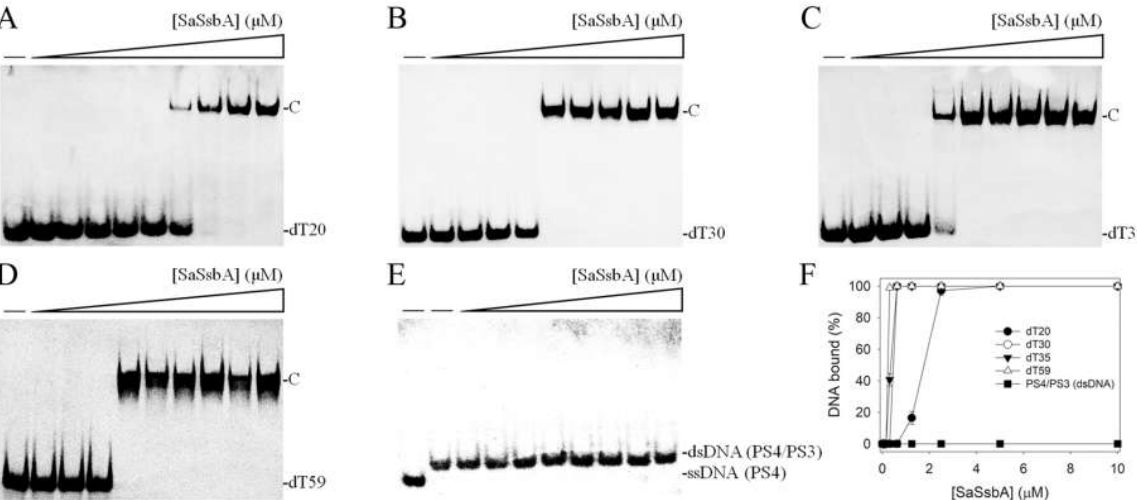
Figure 1. Binding of SaSsbA to ssDNA and dsDNA. Purified SaSsbA (0, 0.039, 0.078, 0.156, 0.312, 0.625, 1.25, 2.5, 5, 10 μM) was incubated with the biotin-labeled ssDNAs ( A ) dT20, ( B ) dT30, ( C ) dT35, and ( D ) dT59 at 37 °C for 60 min. ( E ) Results of binding test of SaSsbA to dsDNA. Purified SaSsbA (0, 0.078, 0.156, 0.312, 0.625, 1.25, 2.5, 5, 10 μM) was incubated with the dsDNA PS4/PS3, of which the DNA strand PS4 was biotinylated. SaSsbA was not able to produce a band shift with this dsDNA. ( F ) ssDNA-binding abilities of SaSsbA. The binding constants ([Protein] 50 ) were quantified through linear interpolation based on the protein concentration.